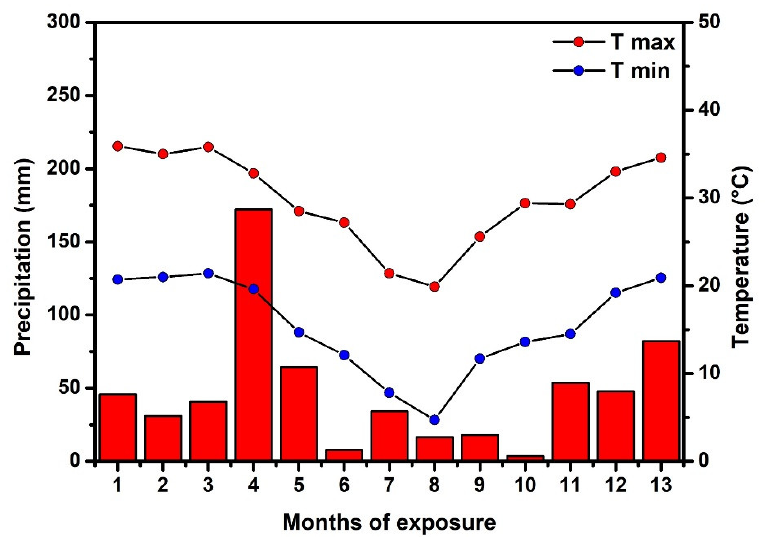
Figure 10. Averaged environmental temperatures and amount of rain during the months of outdoor exposure.